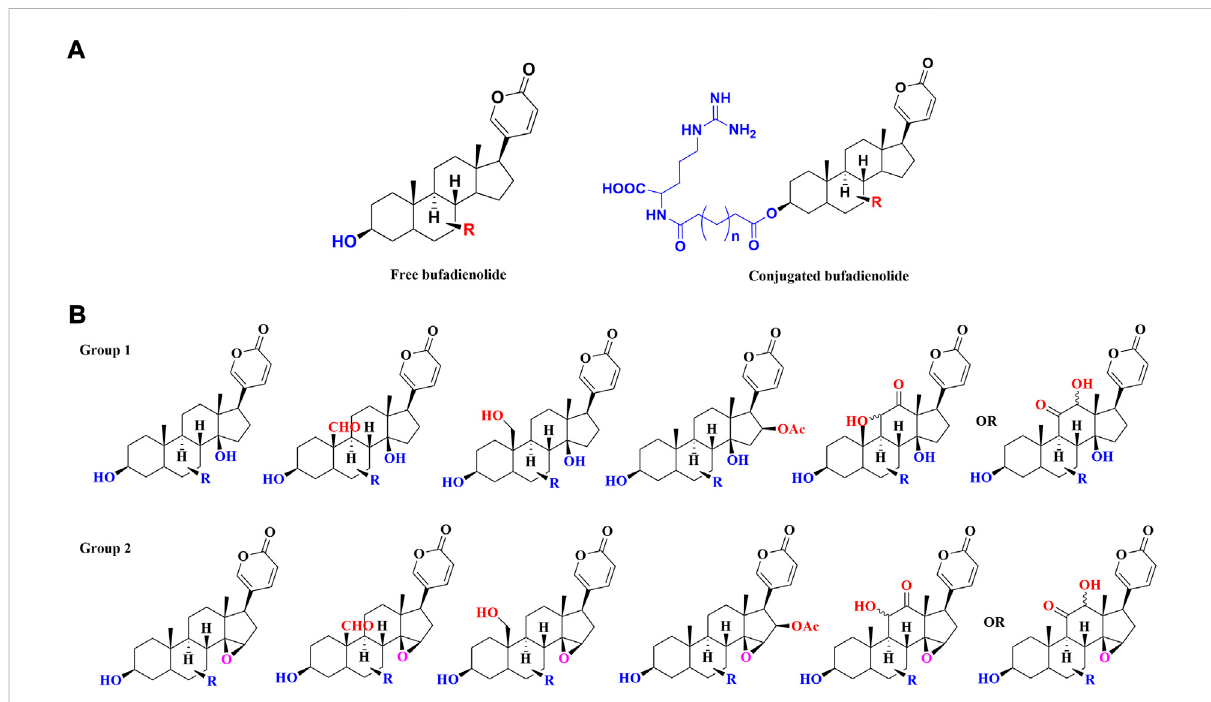
FIGURE 1 Theclassi fi cationoftoad-sourcedbufadienolide: (A) Thetypicalstructuresoffreebufadienolideandconjugatedbufadiendolide; (B) Thetypical structures of fi ve sub-categories of free bufadienolide according to the contained